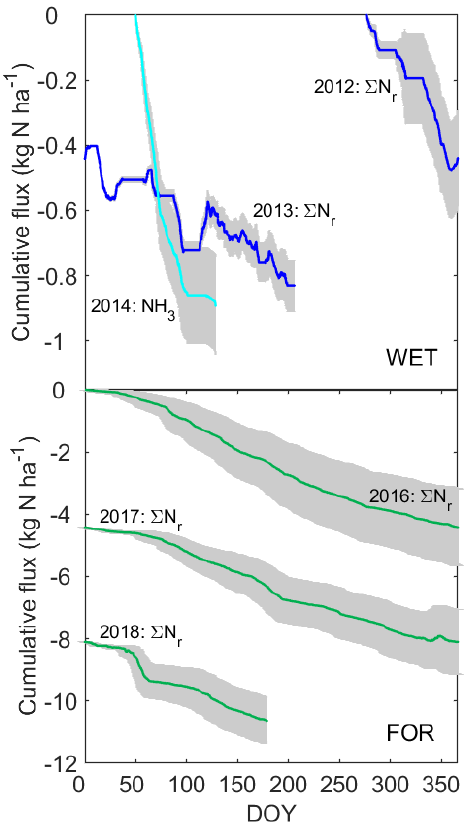
Figure 6. Cumulative campaign fluxes; larger gaps at the WET site were not further interpolated; negative cumulative flux values in- dicate overall deposition of nitrogen; grey shaded areas represent uncertainty (see Sect. 4.5 for